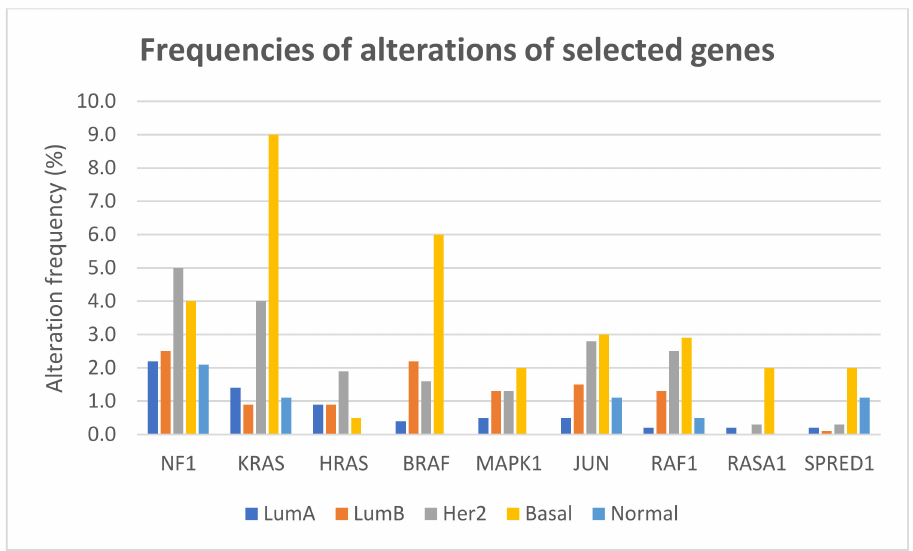
Figure 4. Frequencies of alterations (including mutations, CNAs, and structural variants) of selected genes of the RAS/RAF/MEK/ERK pathway in different breast cancer